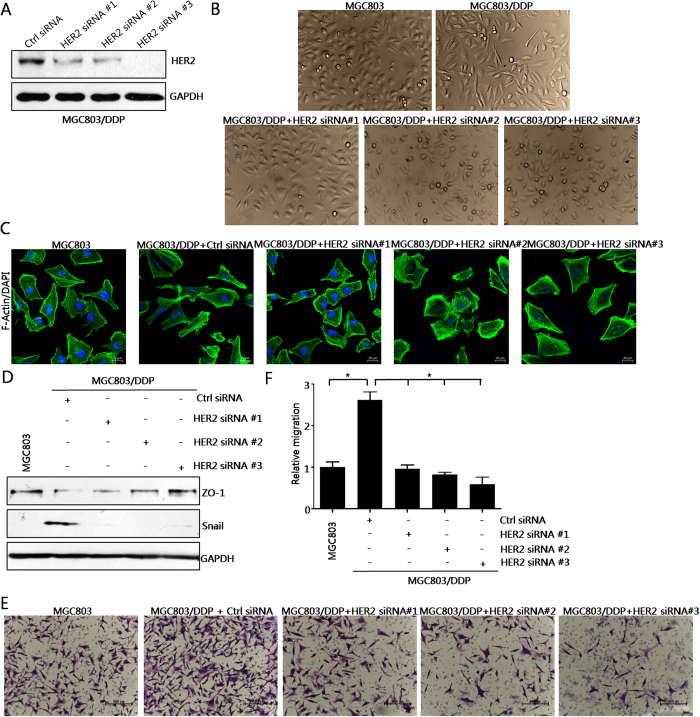
SiRNAs against HER2 could abrogate the EMT phenotype and cell invasiveness in cisplatin-resistant gastric cancer cells.(A) Validation of silencing efficiency of HER2. Cells were transiently transfected with 50 nM HER2-specific siRNAs #1-#3 or a control siRNA for 48 h. (B) Knock-down of HER2 abrogated EMT morphology. Cells were transiently transfected with 50 nM specific siRNAs targeting HER2 for 48 h, Representative images of cellular morphology were shown. (C) Knock-down of HER2 abolished EMT phenotype. Cells were treated as in Fig. 4B. FITC-phalloidin staining of F-actin were performed and representative images were shown. (D) Effects of HER2 knock-down on the levels of ZO1 and Snail. (E) Effects of HER2 knock-down on cell migration. Representative images of transwell cell migration assay were shown. (F) Summary of Fig. 4E. Values represented the mean ± SD from three independent experiments with triplicate samples. *P < 0.01.